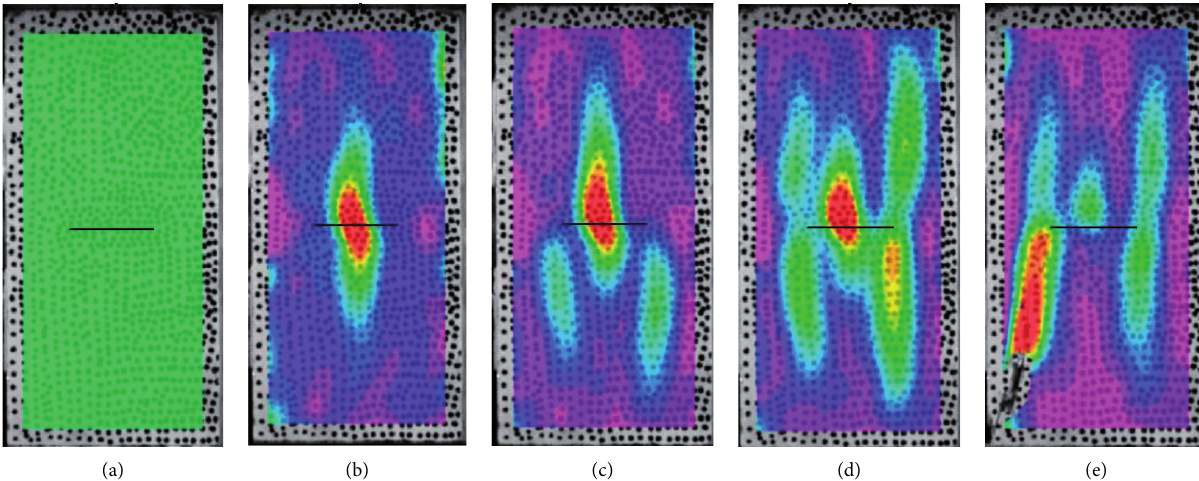
Figure 8: Stress field developed at different times for the specimen with α � 0 ° . (a) t � 0s. (b) t � 360s. (c) t � 590s. (d) t � 695s. (e) t �